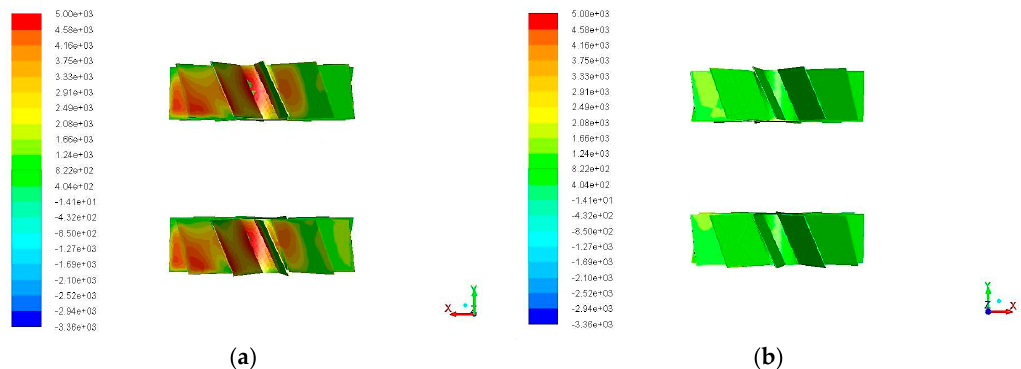
Figure 15. Static pressure (Pa) distribution ( a ) on the contested surface; ( b ) on the non-contested surface of two-stage KIONAS, rotor blade angle of 25 degrees and stator with curved guide vanes. From Figures 16–18 the velocity vectors and the contours of velocity for two-stage KIONAS, stator with curved guide vanes and rotor blade angle of 25°, 30° and 35° are illustrated. The most